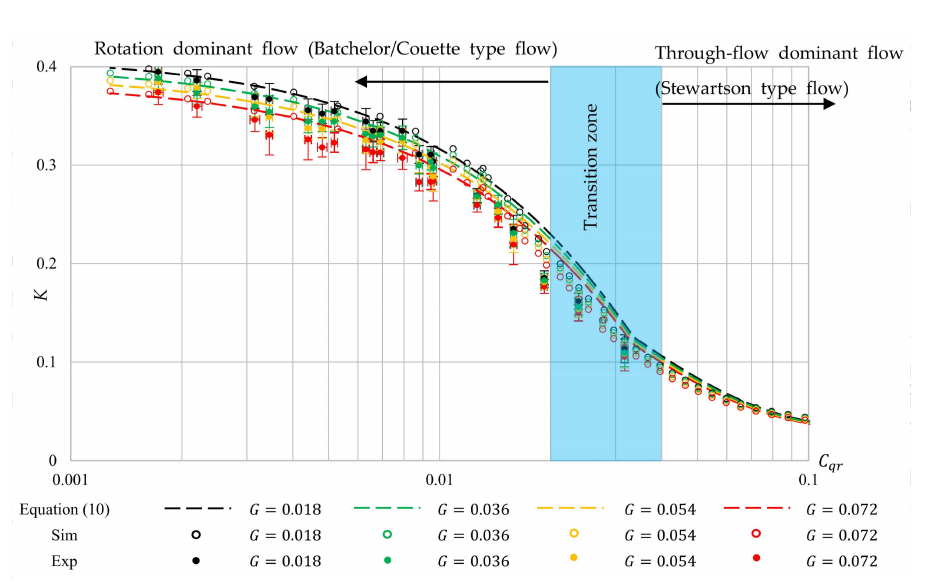
Figure 8. K ( C qr ) curves. C qr : local flow rate coefficient; G : non-dimensional axial gap; K : core swirl